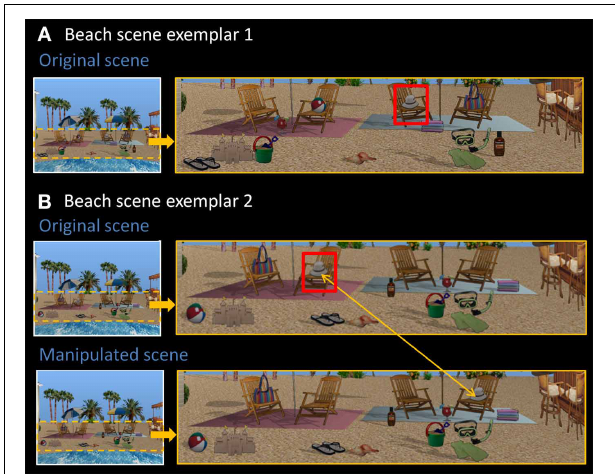
FIGURE 1 | Stimuli used in Experiment 1. (A) Exemplar 1 of the beach scene. (B) Exemplar 2 of the beach scene, along with its manipulated version. Comparing original exemplars 1 and 2, all eight critical items (sandals, sand bucket, margarita drink, beach ball, hat, towels, bag, sunscreen) have been rearranged into a different spatial configuration. The hat, for example, is now located on the second chair from the left. Red boxes are for illustrative purposes only. In the manipulated version, the critical item (i.e., the hat) has moved from the chair on the left side of the scene to the chair on the right side of the scene, constituting a change in spatial relationships.